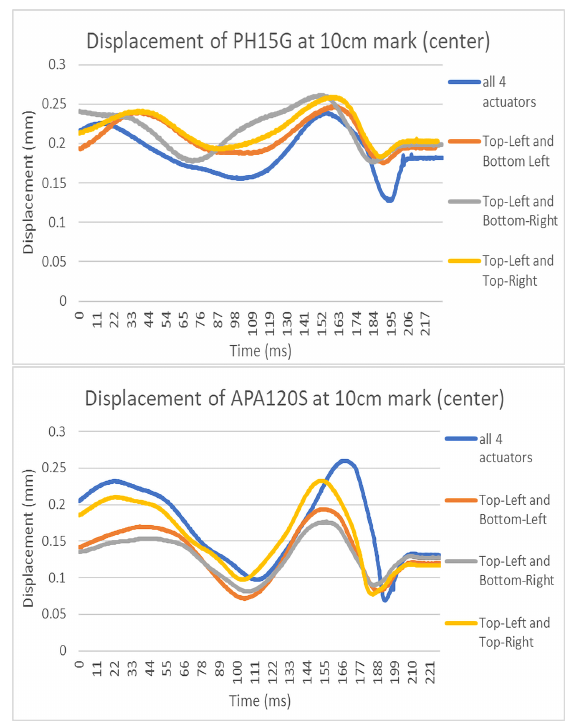
Figure 9. Displacement measured from PowerHap 15G and APA120S